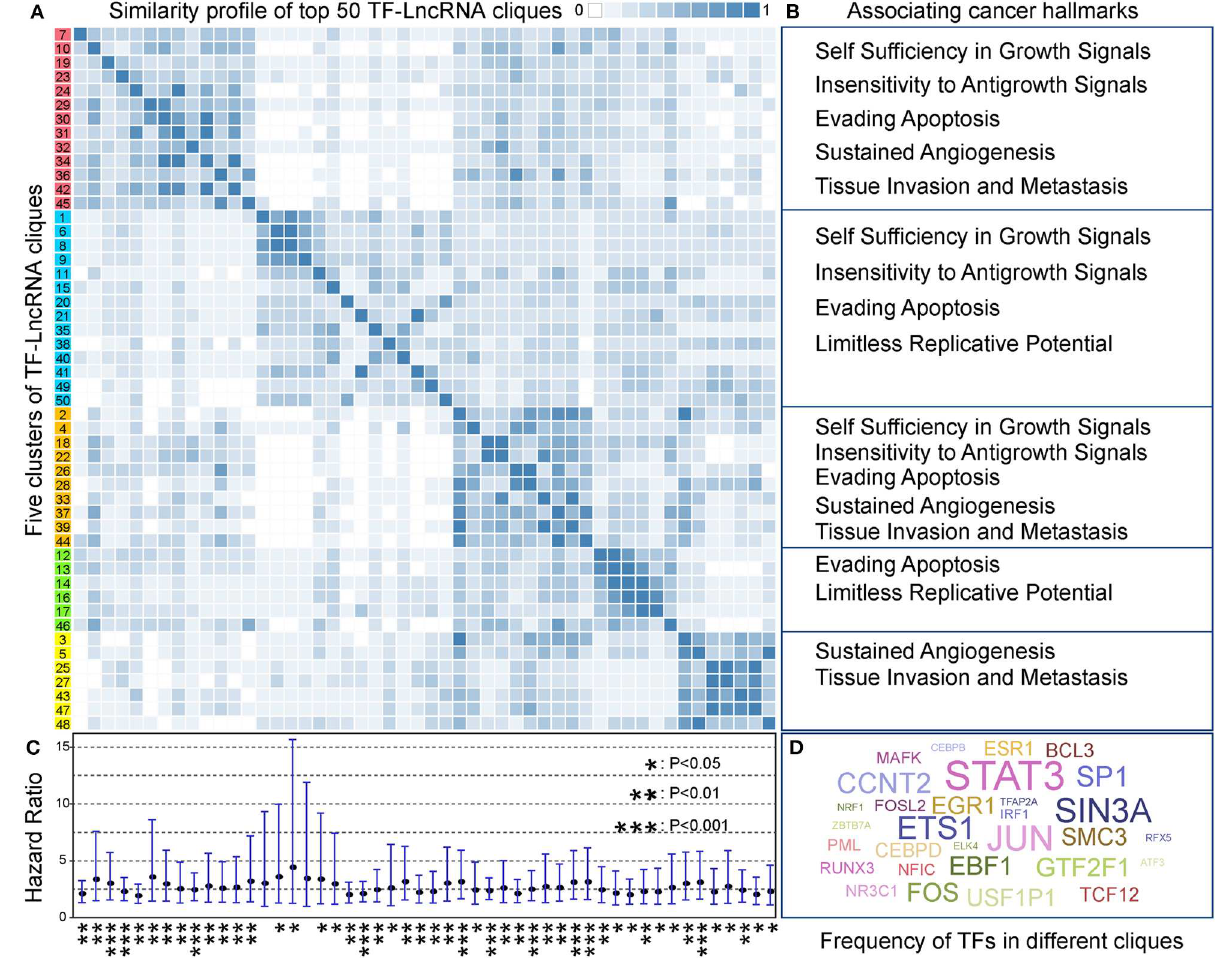
FIGURE 5 | TF-lncRNA regulatory cliques are associated with cancer hallmarks. (A) Clustering profile of the top 50 cliques based on their similarity. (B) Different clusters of cliques were associated with a broad range of cancer hallmarks. (C) The hazard ratio and 95% confidence interval for each of the 50 TF-lncRNA cliques based on Cox regression analysis. Most of the cliques (48 of 50) were significantly associated with patient prognosis ( P < 0.05). * P < 0.05, ** P < 0.01, and *** P < 0.001. (D) A world cloud map indicating TF frequency in the 50 cliques. Some well-known cancer prognostic genes such as STAT3, ETS1, and FOS were frequently involved in different